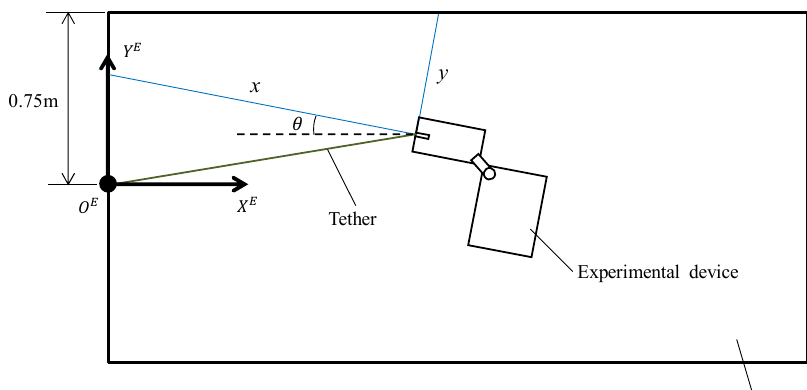
Figure 9. State of the experiment.